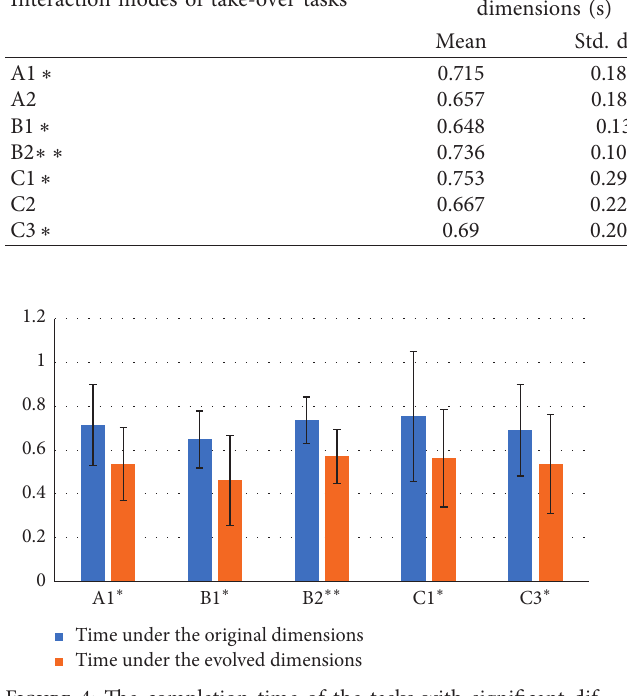
Table 6: The paired sample t -test results of task completion time under the two HMIs with different dimensions. Interaction modes of take-over tasks